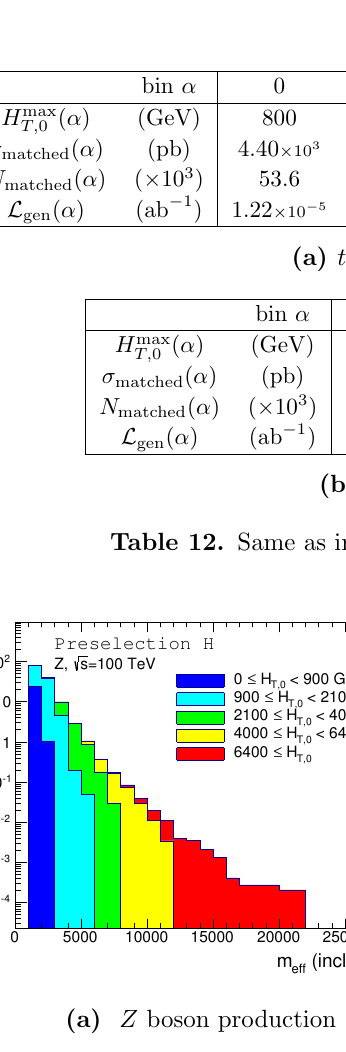
(a) Semi-leptonic t (cid:22) t decay (b) Leptonic t (cid:22) t decay Figure 16. Same as in (cid:12)gure 15, but for the t (cid:22) t production process.